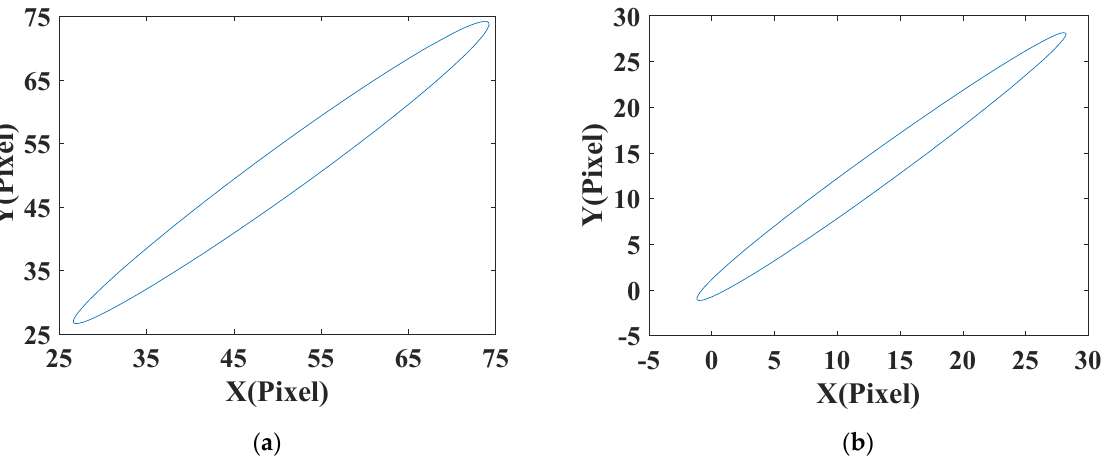
Figure 8. The center of the TLS when ∆ θ changes from 1 ◦ to 360 ◦ . ( a ) H ( b ) H R 2 = V R 2 = 0.1 ◦